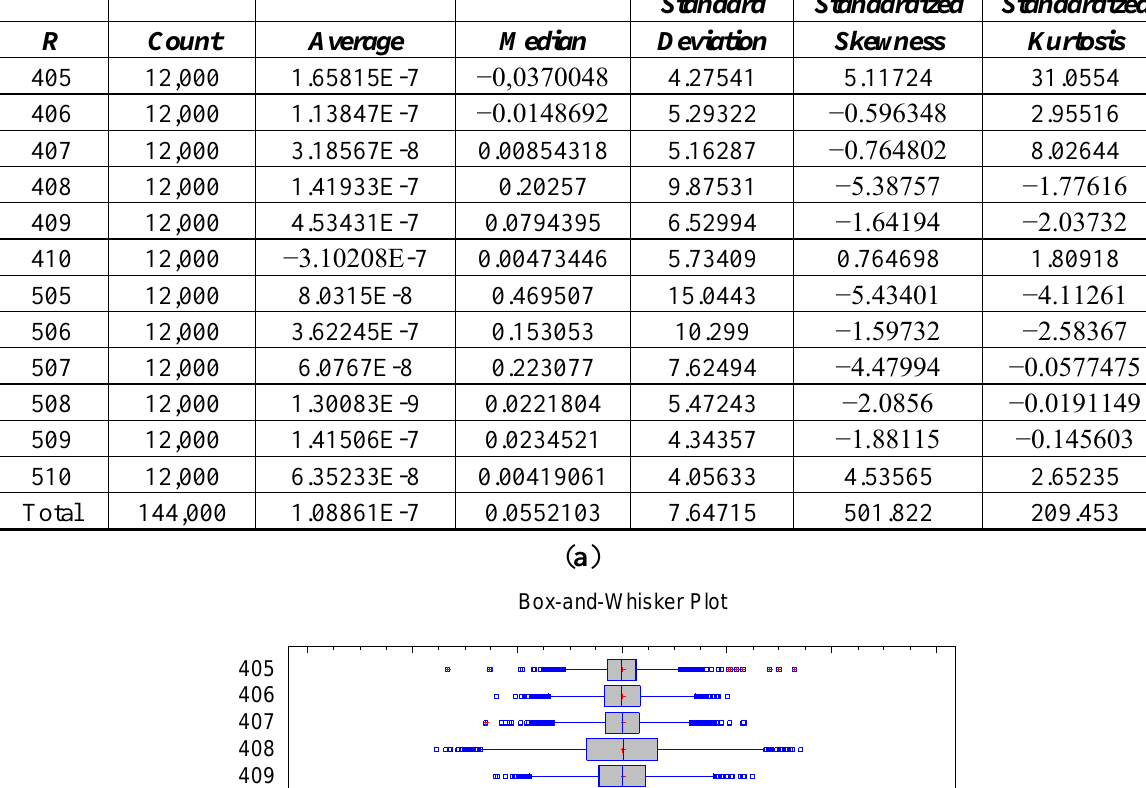
Figure 6. Descriptive statistics ( a ) and plots ( b ) for the residuals of the wavelength R (red) for the 12 levels of the reflectance